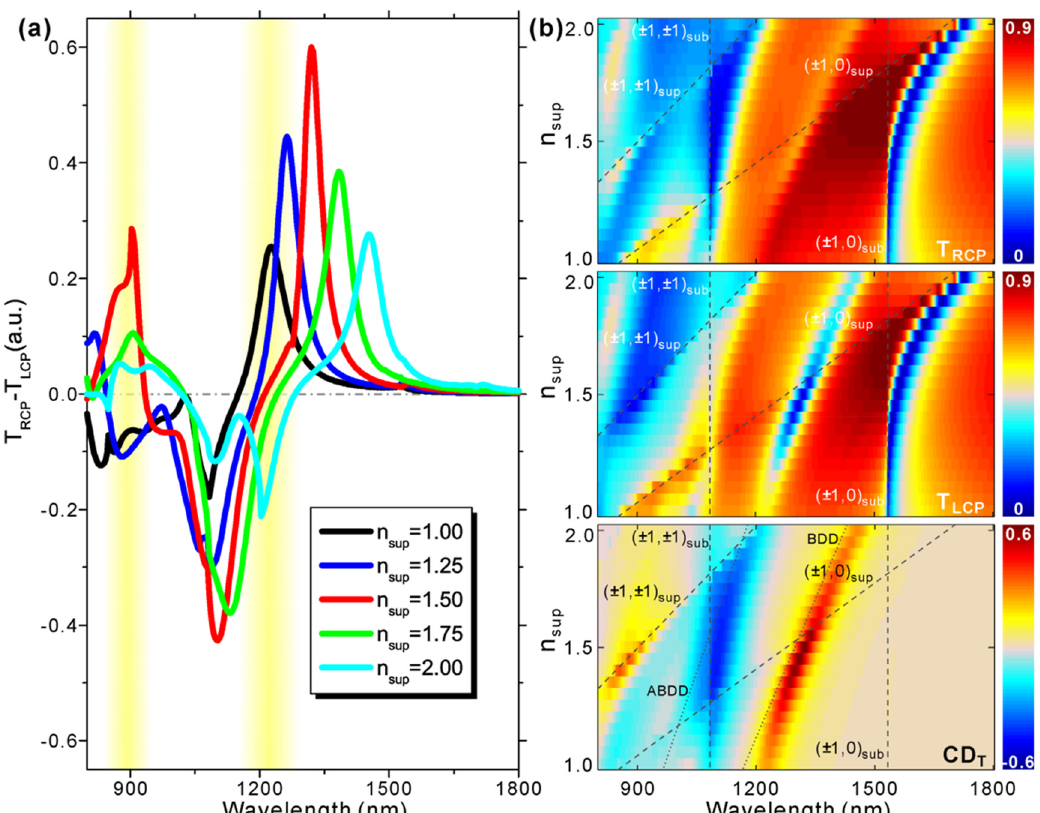
Figure 9: DynamictuningofCDresponses.(a)TheCDspectraintransmissionunderdifferentsuperstrateindexesforthesamechiralquadrumer array,where the sign of CD signalis switchedaroundthe spectral positionsmarked withyellow bars. (b)Transmission spectra underRCP(upper panel)andLCP(middlepanel)incidences,aswellastheCDresponses(lowerpanel)forthequadrumerarrayunderdifferentsuperstrateindexes. The dashed lines show the spectral position of RAs, and the dotted lines in the lower panel denote the evolution of ABDD and BDD